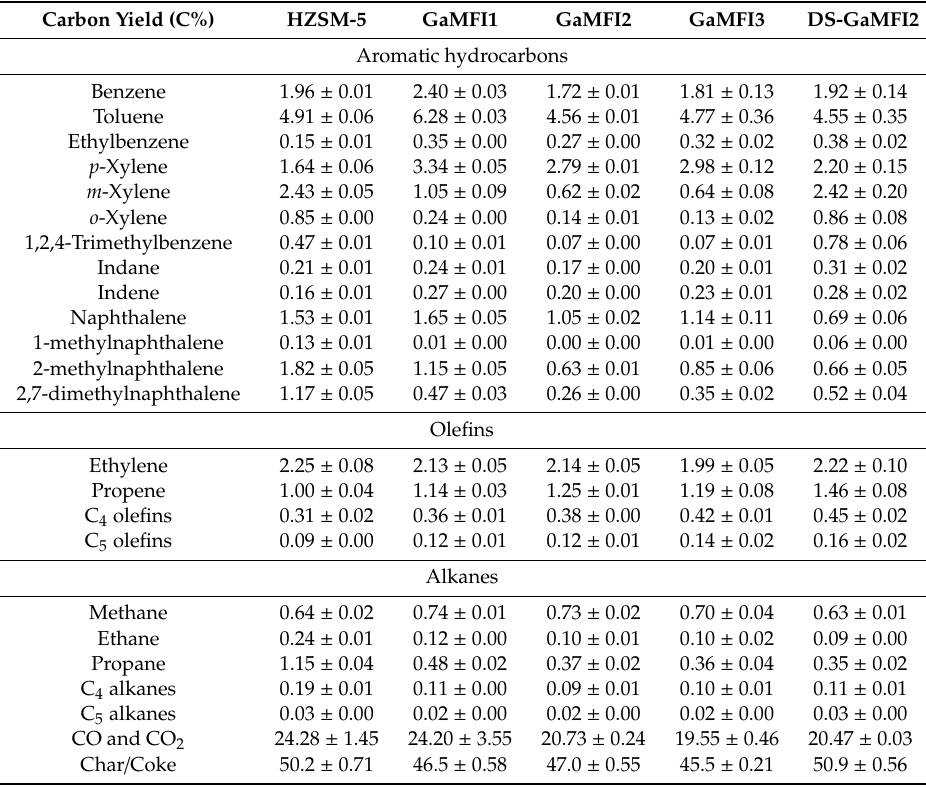
Table 2. Product distribution in CFP of beech wood with HZSM-5 and Ga-containing MFI zeolites. Carbon Yield